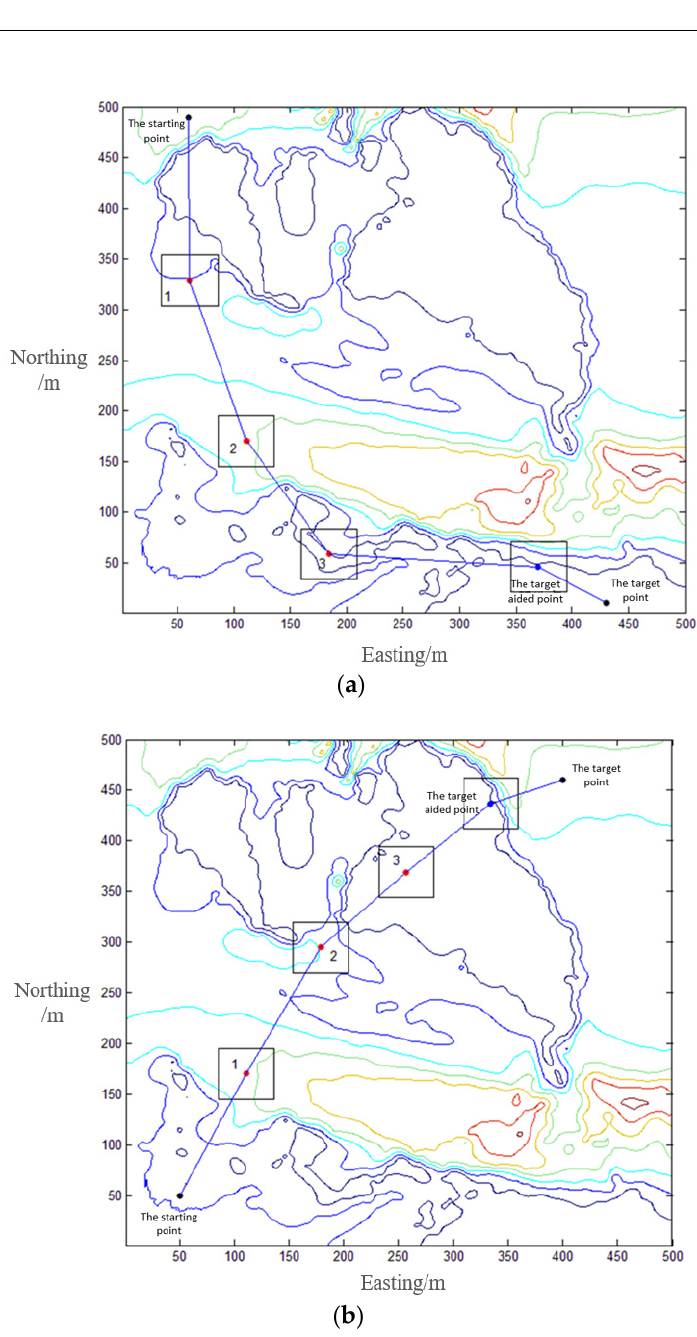
Figure 16. The generated path in case study 4. ( a ) The path according to the points demonstrated in the Table 9; ( b ) The path according to the points demonstrated in the Table 10.